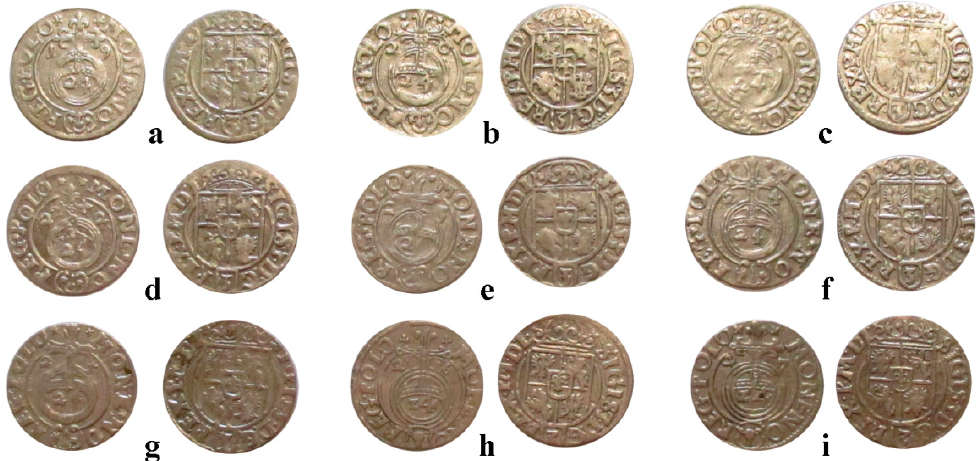
Figure 1. The3-Polker coins issued by Sigismund III of Poland investigated in the current re- search.Minting years: ( a ) 1619, ( b ) 1620, ( c ) 1621, ( d ) 1622, ( e ) 1623, ( f ) 1624, ( g ) 1625, ( h ) 1626, and ( i ) 1627. Coins’ dimensional characteristics are given in Table 1.